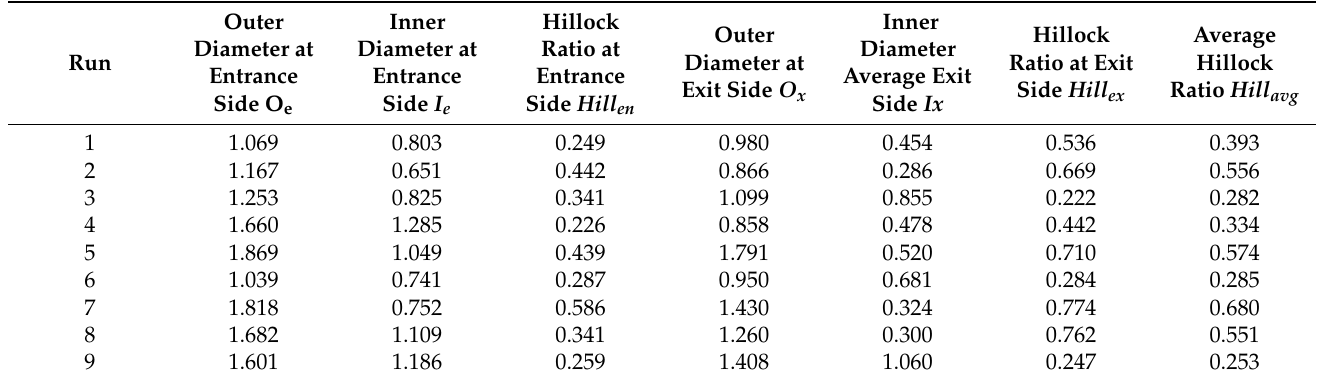
Table A2. Measured data and quality calculation results for average Hillock ratio.